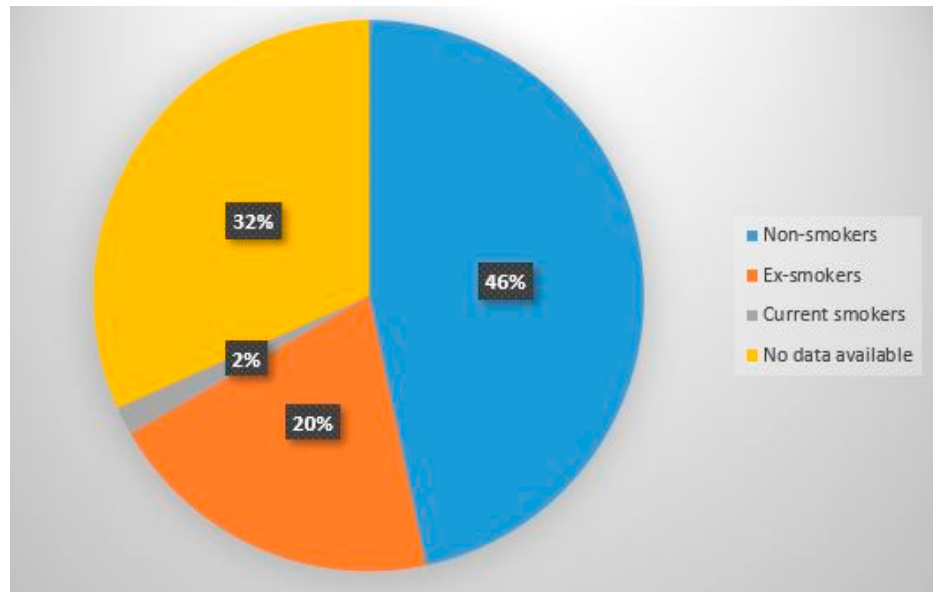
Figure 2. Proportion of patients exposed and not exposed to cigarette smoke.